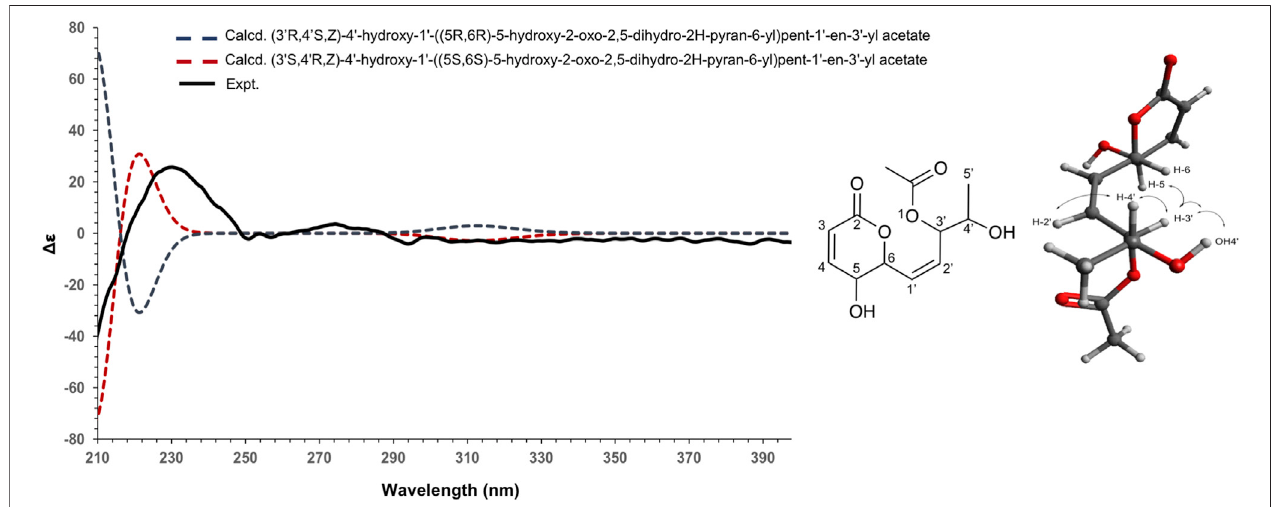
FIGURE 5 | Experimental (black) and TFT-TD-calculated ECD spectra of the two enantiomers (3 ’ R ,4 ’ S ,Z), (5R,6R) (blue), and (3 ’ S ,4 ’ R ,Z), (5S, 6S) (red) of compound 3.